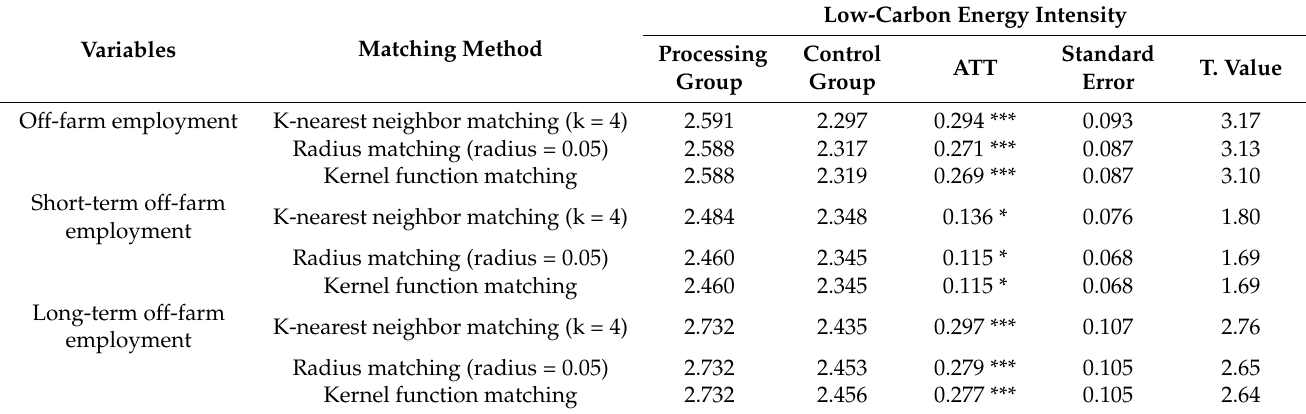
Table 7. Matching estimation results of propensity score (N =